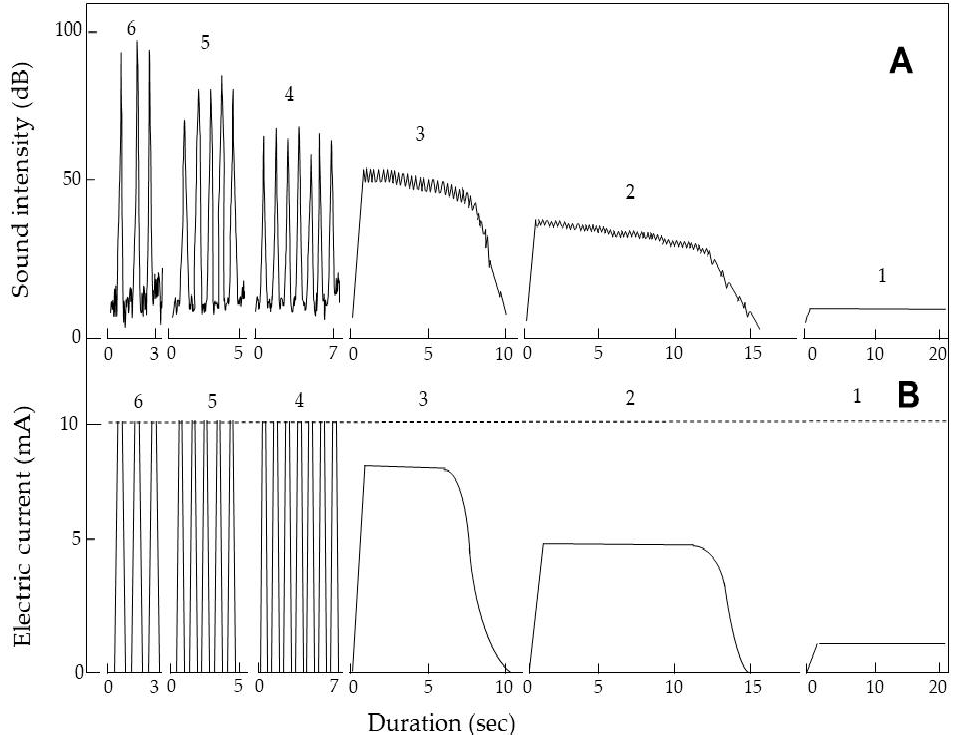
Figure 4. Sound spectrogram ( A ) and electric current profile ( B ) in parallel with electric discharge exposure. Numbers (1–6) in the figure represent the distance (mm) between the negatively charged iron plate and the plant shoot that was subjected to arc-discharge exposure. Intermittent arc discharge occurred at 4–6 mm, continuous arc discharge occurred at 2 and 3 mm, and silent discharge occurred at 1 mm. The magnitude of the electric current resulting from intermittent arc discharge was not measured because the current immediately exceeded the detection limit (10 mA).